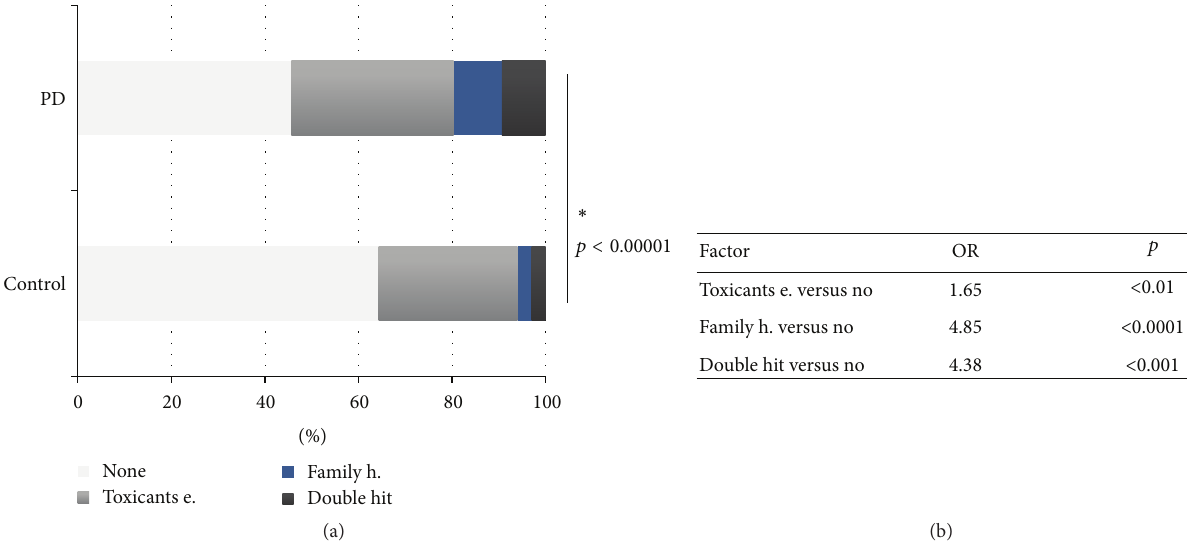
Figure 1: (a) Distribution of risk factors in the two groups (no factors, toxicants exposure, positive family history, “double hit,” or positive family history + toxicants exposure). (b) OR of these risk factors. ∗ means statistical significance.